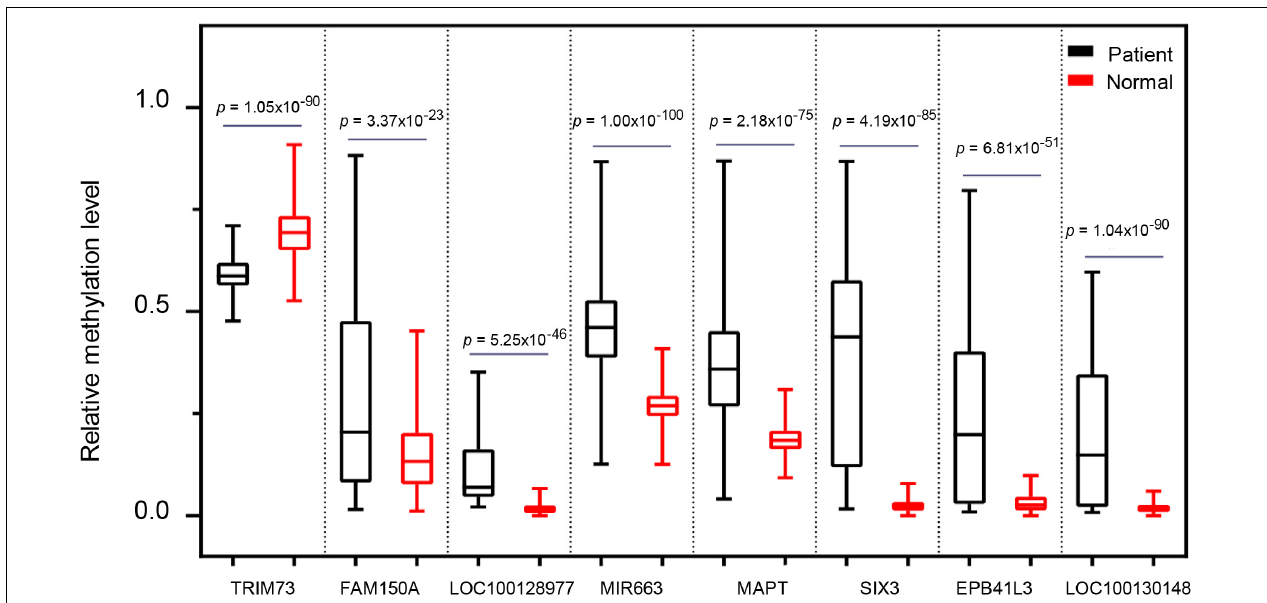
FIGURE 7 | The comparison of the methylation level of the eight selected markers between pancreatic cancer patients and healthy controls.